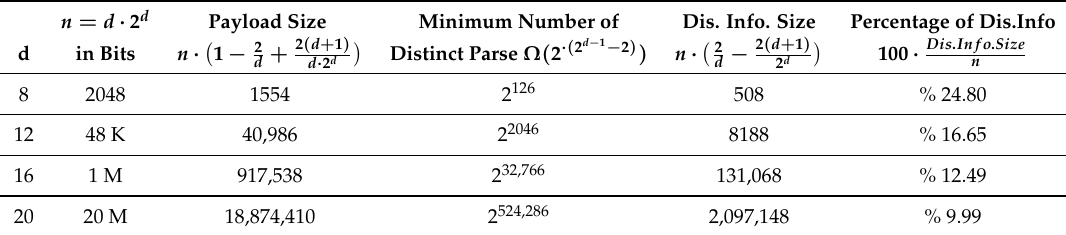
Table 3. When n = d · 2 d , the payload size, the disambiguation information size, and the corresponding number of possible decodings are shown. Last column depicts the percentage of the volume to be encrypted to provide privacy with the specified level of ambiguity, i.e., when d = 8, encrypting only around 25% of the input volume (2048 bits) introduces an ambiguity of around 2 126